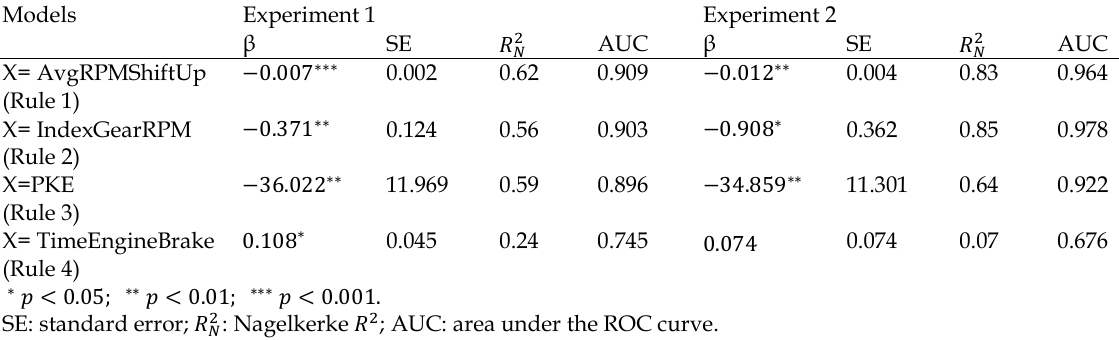
Table 5. Logistic regression models for 50km/h speed limit.